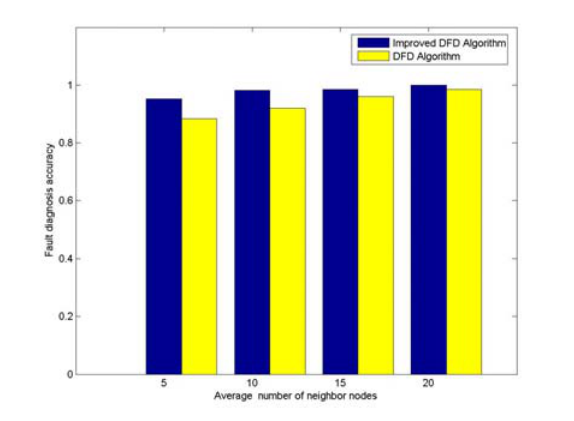
Figure 2. The trend of node fault detection accuracy with various average numbers of neighbor nodes when 200 nodes are deployed and the node’s failure ratio is